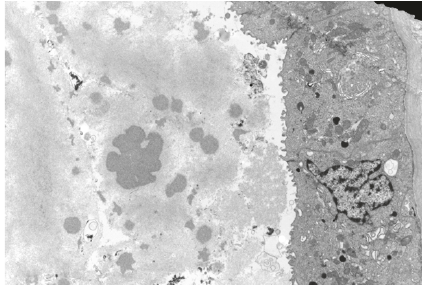
Figure 4: Electron micrograph of portion of cast shows light and dark areas with fine granular appearance. The tubular basement membrane seems